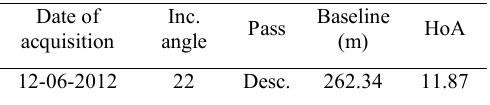
Table 1: TanDEM-X image